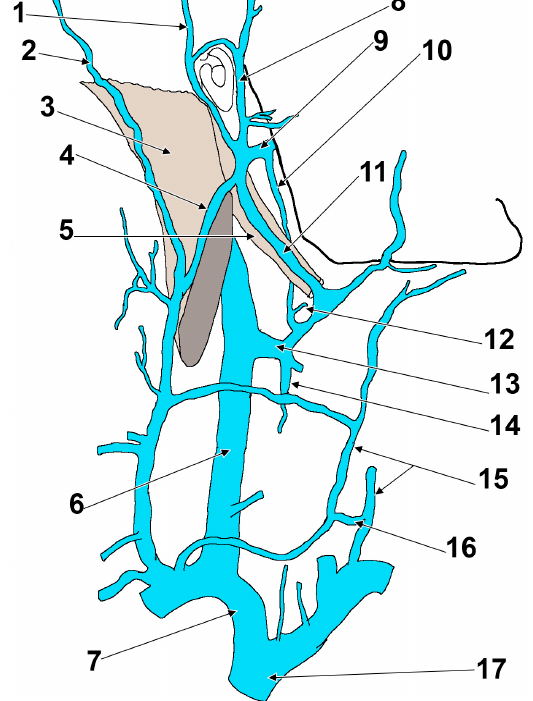
Figure 6. Drawing, modified after Rouvière and Delmas (1985), depicting the veins on the right side of the neck. 1. Posterior auricular vein; 2. superficial occipital vein; 3. sternocleidomastoid m.; 4. external jugular vein; 5. posterior belly of digastric m.; 6. internal jugular vein; 7. right brachiocephalic vein; 8. superficial temporal vein; 9. maxillary vein; 10. external carotid vein of Launay; 11. intraparotid communicating vein; 12. lingual vein; 13. thyro-linguo-facial trunk; 14. superior thyroid vein; 15. anterior jugular vein; 16. jugular venous arch; 17. superior vena cava.